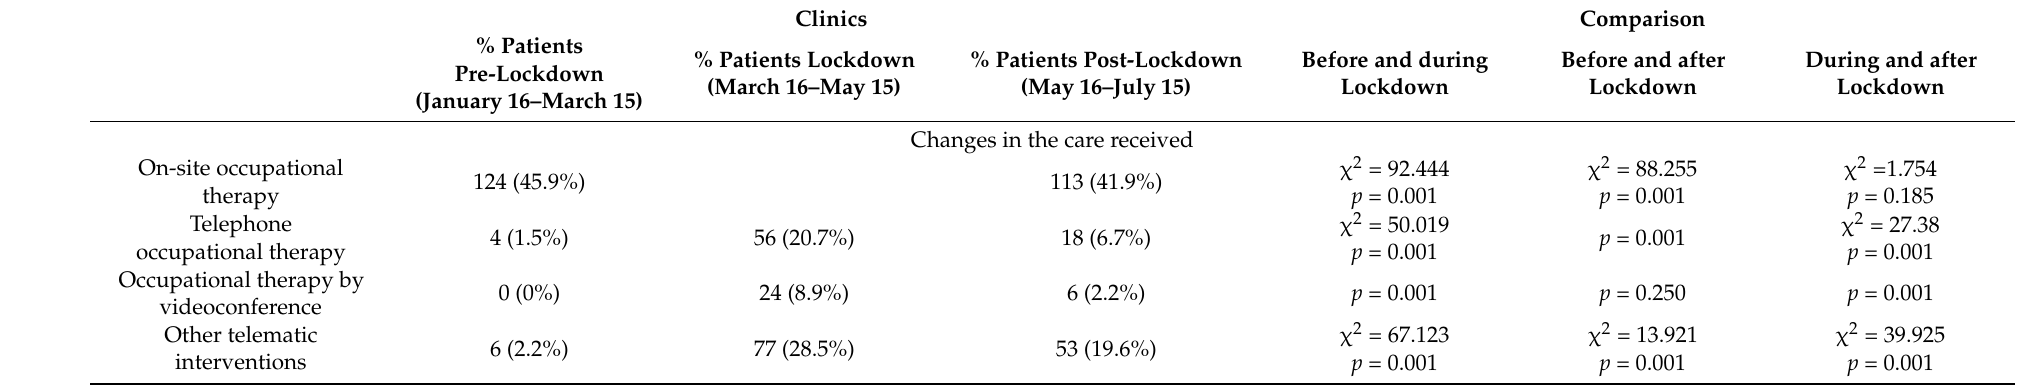
Table 2. Time periods in the pandemic and changes in care